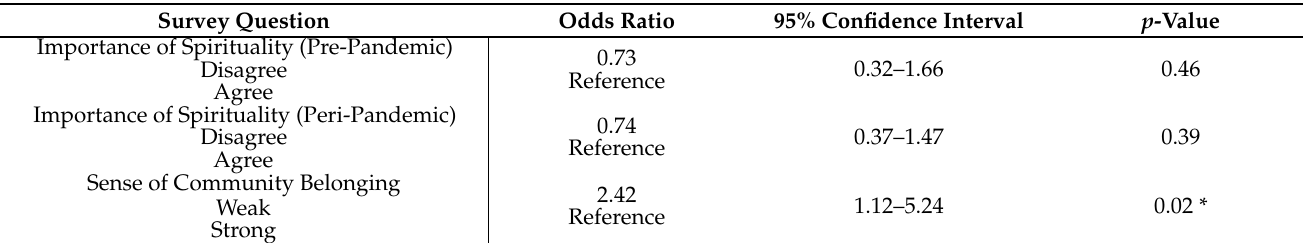
Table 2. Adjusted logistic regression of the association between the importance of spirituality and sense of community belonging with symptoms of anxiety (GAD-2 score ≥